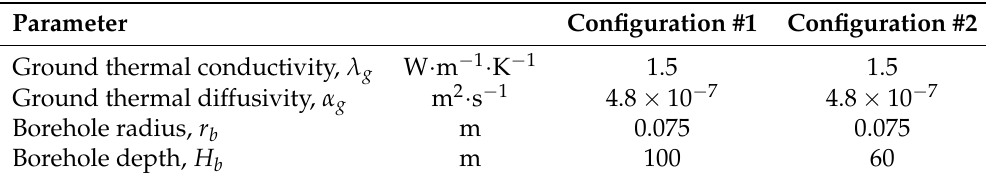
Table 2. Parameters for the two analyzed